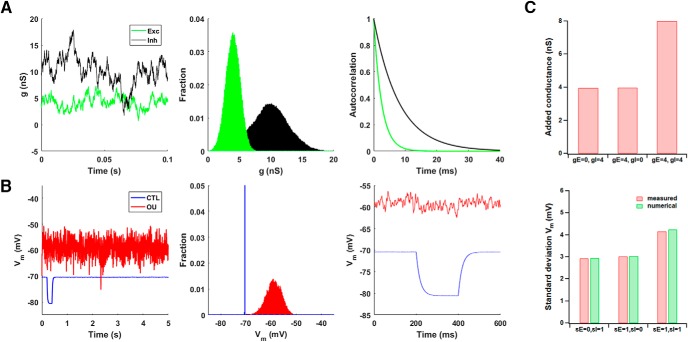
Synaptic background activity. A, In the point conductance model of Destexhe et al., (2001), synaptic background activity is modeled by two noisy conductance trains. One represents excitatory input, and the other represents inhibitory input; both are generated by Ornstein–Uhlenbeck processes. Each train is normally distributed (middle) and is correlated at short times (right; the power spectrum goes like 1/f
2 for higher frequencies). B, Without background activity, the model cell has a flat membrane potential (left) that is almost constant (middle); its input resistance is large (right). Adding in vivo–like background activity depolarizes the membrane, introduces membrane potential fluctuations, and reduces the input resistance. The vertical scale of the middle histogram is truncated so that the membrane potential distribution in the active state is easier to see. C, Varying the mean (g, in nanoSiemens) and standard deviation (s, in nanoSiemens) of the excitatory and inhibitory conductances produced the predicted changes in total conductance (top) and membrane potential fluctuations (bottom). The added conductance is expected to equal the sum of gE and gI. The numerical estimates of Vm standard deviation were calculated by simulating the model cell. When sE and sI were varied, gE and gI were held fixed at 4 nS.